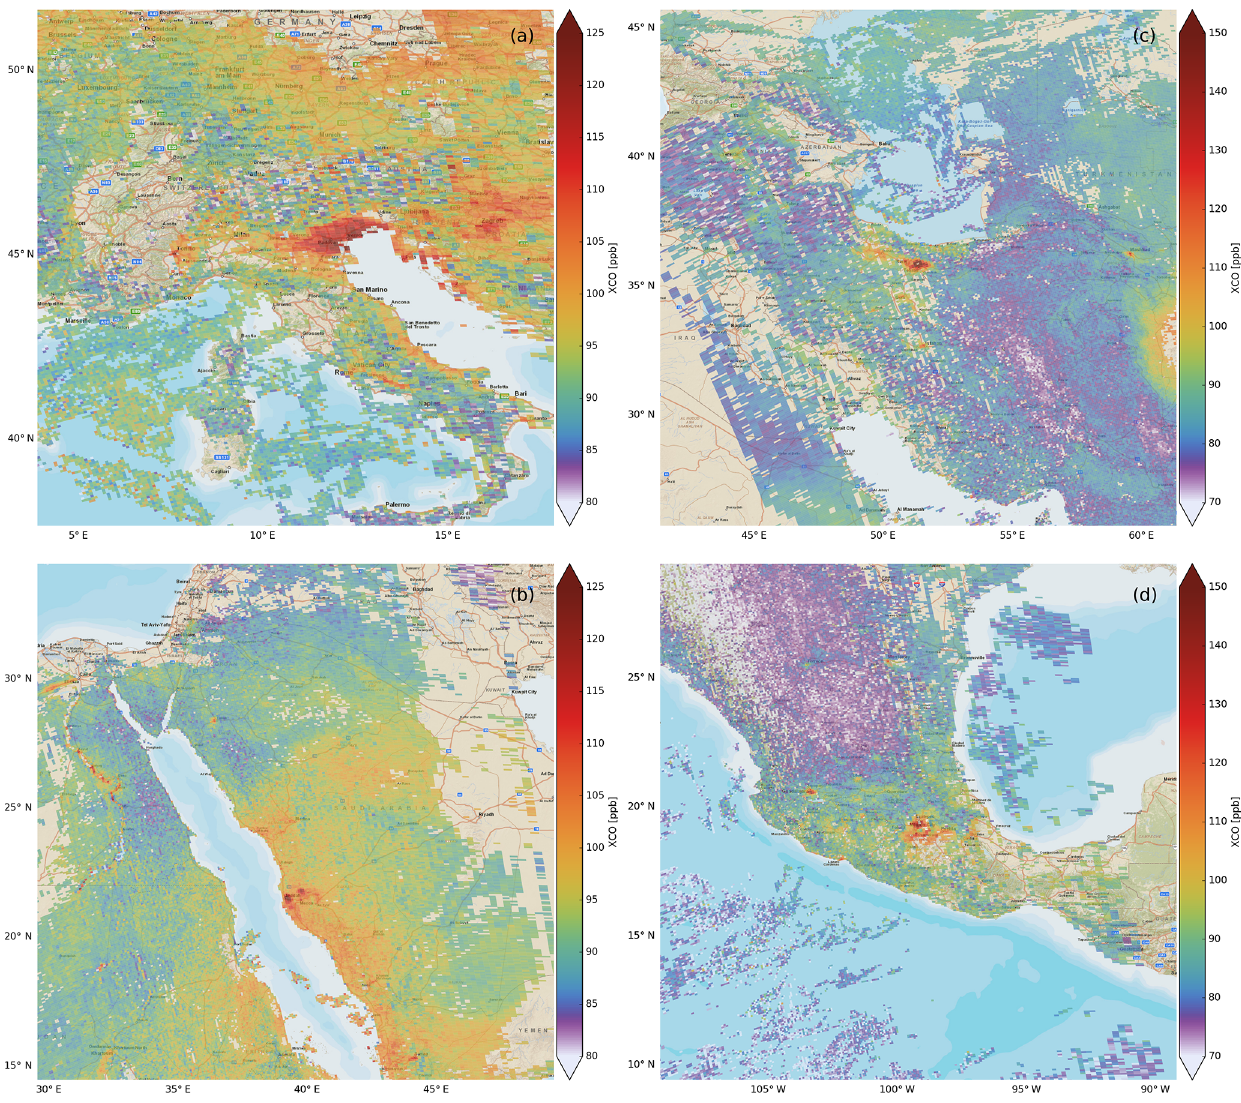
Figure 6. Total column mixing ratio (XCO) for individual TROPOMI ground pixels for (a) Italy on 25 December, (b) Saudi Arabia and Egypt on 12 November 2017, (c) Iran on 17 November 2017, and (d) Mexico on 25 November 2017. De-striping was applied on the TROPOMI